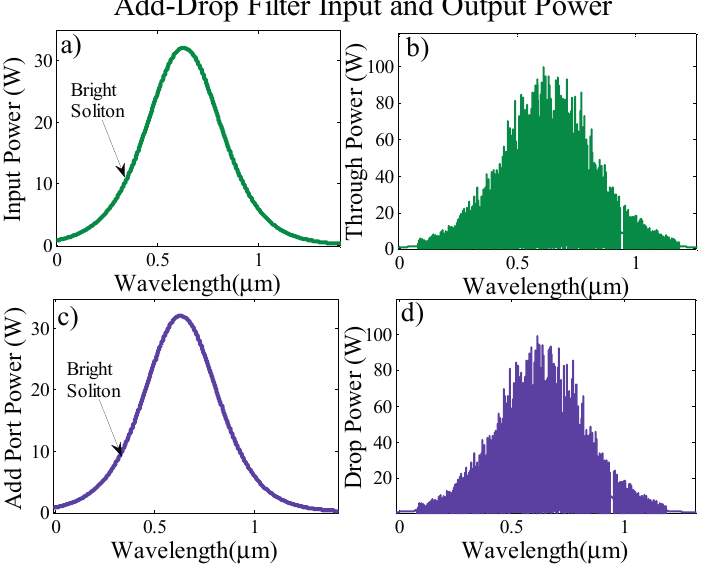
Figure 5. Schematics diagram of DR-ADF microring resonator.